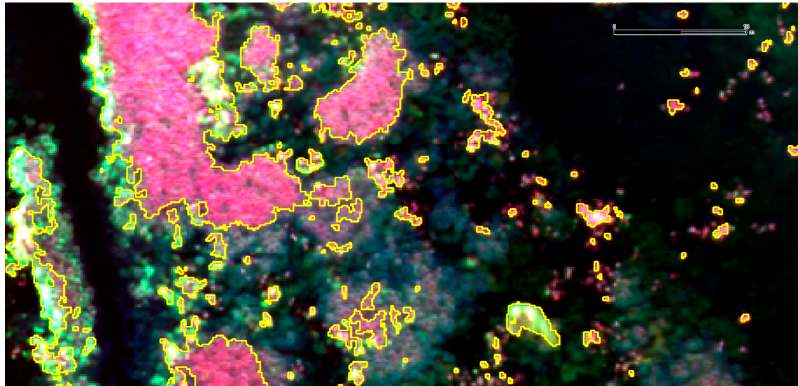
Figure 5. Close ‐ up view of the CIR imagery of study site 2, showing the demarcation (yellow lines) between above ‐ water (redder/brighter) and submerged features (darker) produced by performing a watershed segmentation of the NIR band and classification of the resulting objects based on their mean NIR reflectance.